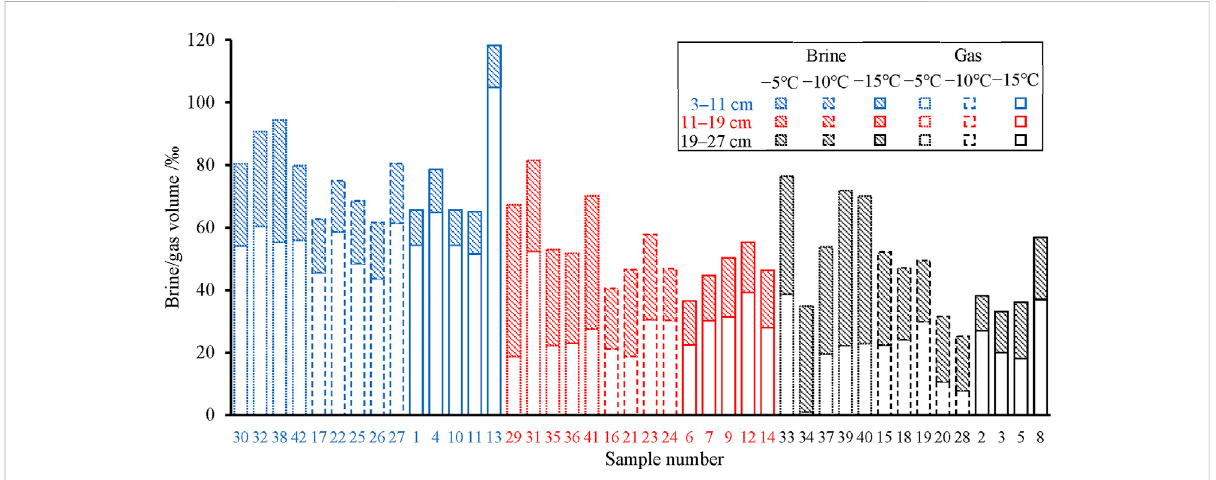
FIGURE 7 Gas and brine volume of each three-point bending sea ice specimen. The sample number corresponds to No. of ice specimens in Table 2. Colors of blue, red, and black represent the ice samples in depths of approximately 3 – 11, 11 – 19, and 19 – 27 cm, respectively. Short dashed, long dashed, and solid lines respect the ice temperatures of − 5, − 10, and − 15 ° C,